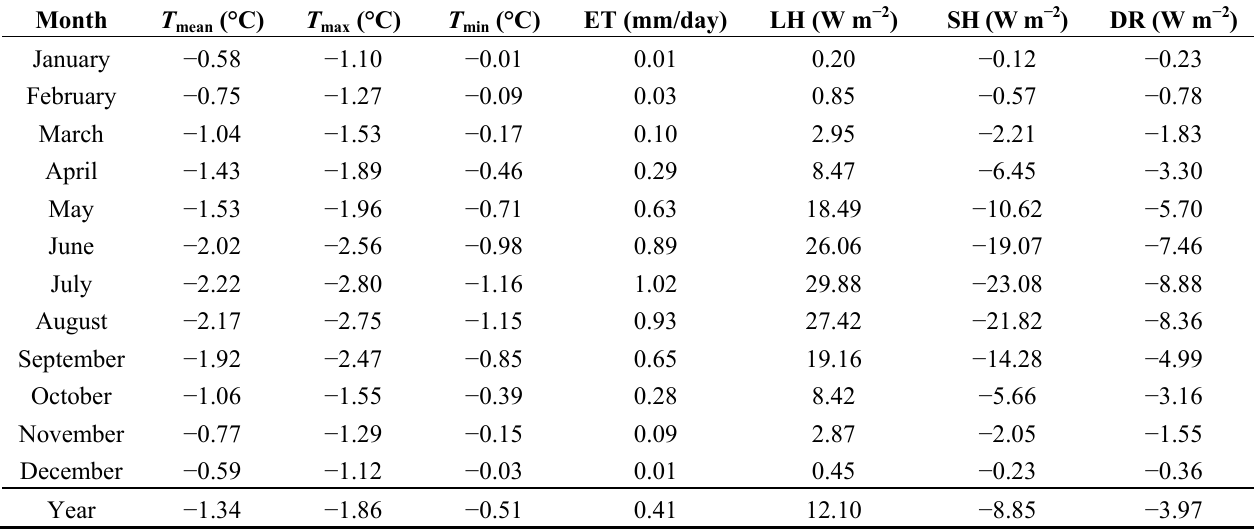
Table 1. Domain-averaged differences for climate variables between CON and IRR.